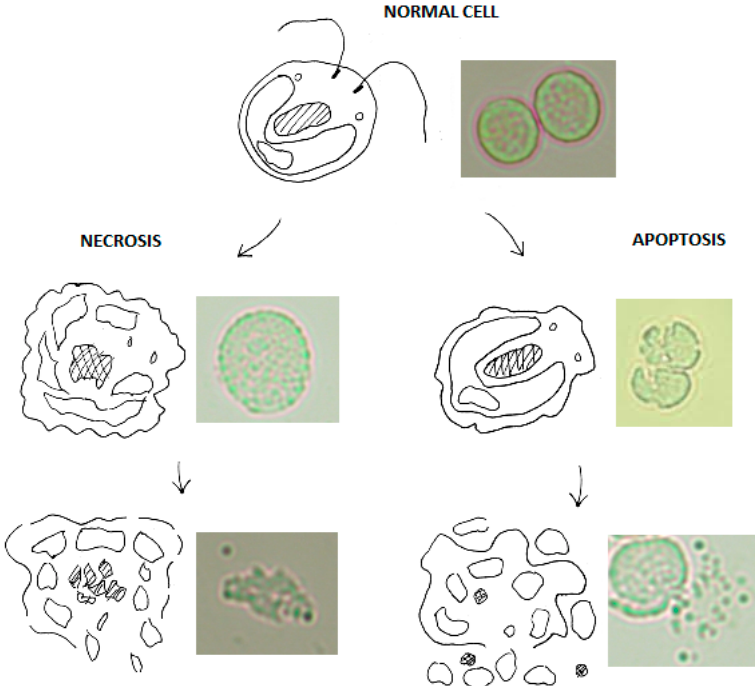
Figure 1. UV induced necrosis and apoptosis of C. reinhardtii cells visualised using Olympus BX50 microscope, 50× objective. Control image of no irradiation of a normal cell. UVB intensity at 1.5 W/cm 2 for 300 s (equivalent to 450 J/cm 2 UVB) for both necrosis and apoptosis. A 3 mL sample of C. reinhardtii in a quartz cuvette was exposed to 300 s of irradiation at 9 W/cm 2 UVA (320–395 nm) and 1.5 W/cm 2 UVB (280–320 nm) at a path length of 3 cm using a BlueWave 75 UV Curing Spot Lamp.